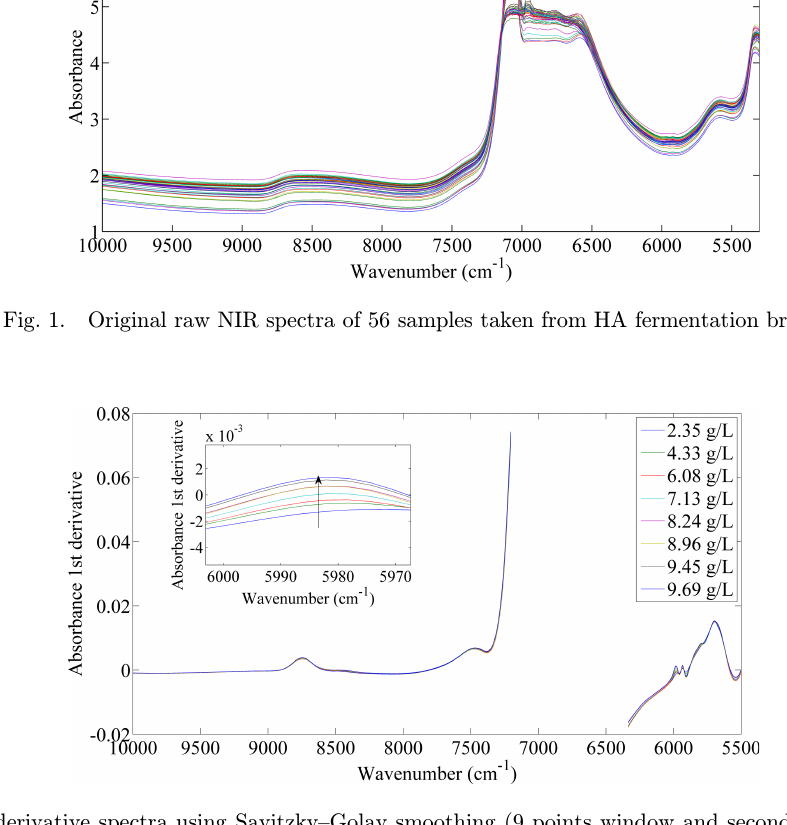
Fig. 2. Plot of ¯rst derivative spectra using Savitzky – Golay smoothing (9 points window and second-order polynomial) of HA fermentation broth. In the small inserted graph, the change of absorbance with HA concentration is shown. The upward-pointing arrow indicated increasing HA